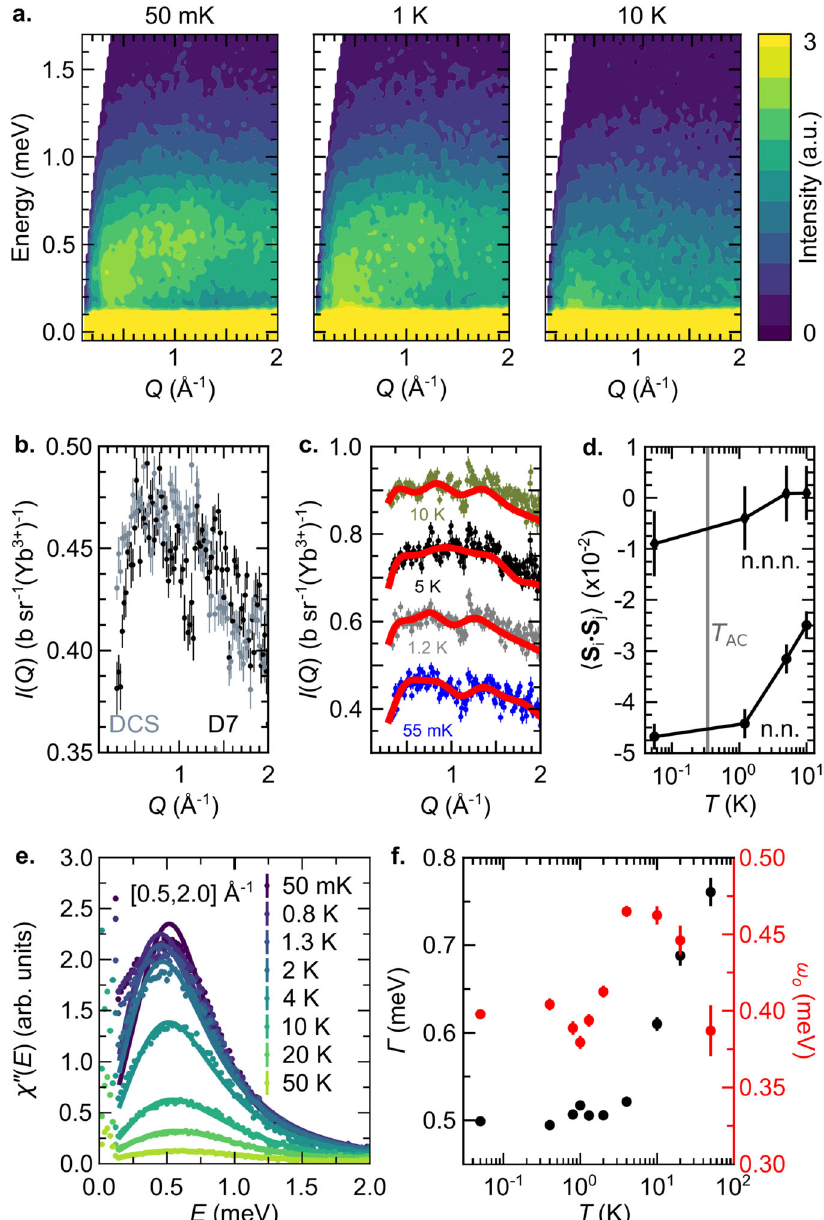
Fig. 4 Evidence for zero- fi eld dynamical ground state in Yb 2 GaSbO 7 . Colour contour plots of the neutron scattering intensity measured on the DCS at ( a ) 50 mK, 1 K, and 10 K. b Comparison of the normalised scattering intensity measured on DCS to the magnetic cross-section measured on D7 at ~50 mK. c Magnetic differential cross-section data from D7 and ( d ) the associated nearest neighbour and next-nearest neighbour spin correlations extracted from the fi ts shown in panel ( c ) and described in the main text. The temperature of the AC susceptibility cusp measured in zero DC fi eld, T AC , is indicated as a reference. For the purposes of clarity, a vertical offset of 0.2 b sr − 1 (Yb 3 + ) − 1 has been introduced for each successive temperature in ( c ). e Calculated fi ts of the imaginary part of the Q -integrated ([0.5, 2.0] Å − 1 ) dynamic magnetic susceptibility to the damped harmonic oscillator model 60 (Eq. (2)) with ( f ) the temperature dependence of its corresponding fi tted parameters: fi ning the peak width and centre, respectively. Uncertainties in the data are statistical in origin and represent one standard Γ and ω o , de deviation, while uncertainties in the fi t parameters represent standard